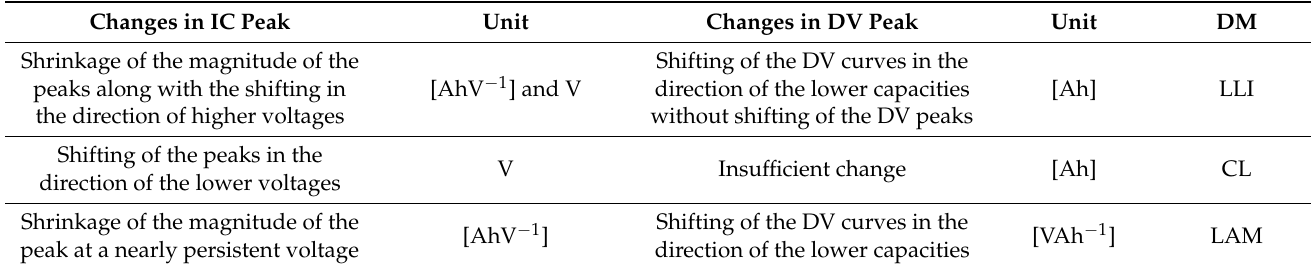
Table 1. Changes of the IC -DV curve with respect to DM.